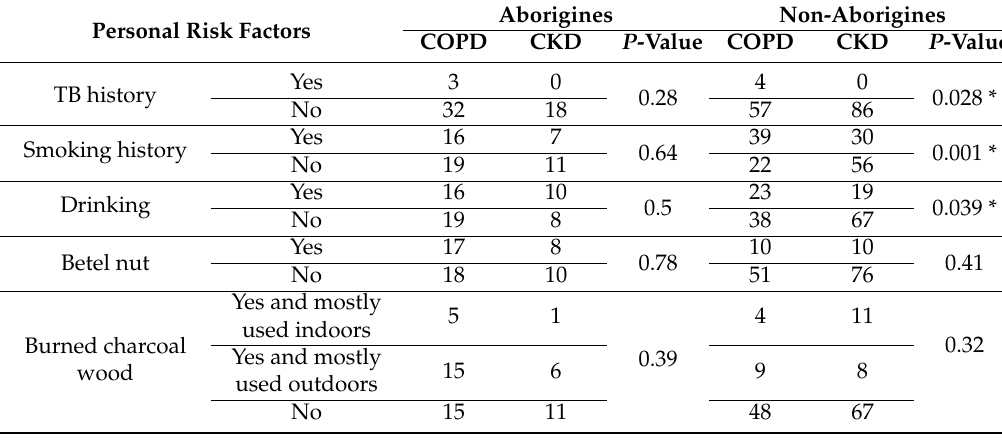
The differences of personal risk factors between COPD and CKD patients stratified by